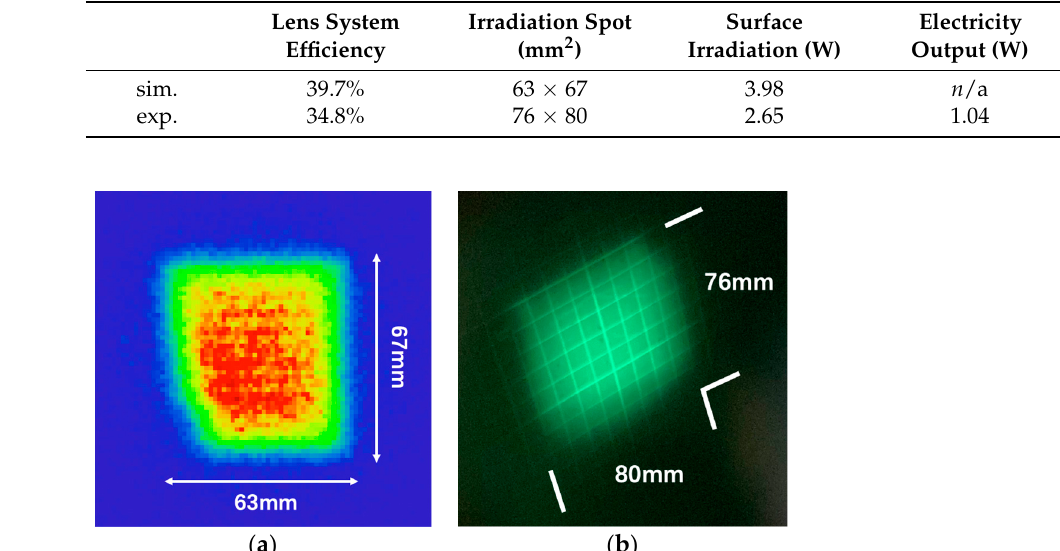
Table 2. Simulation (sim.) and experiment (exp.) results of 3 × 3 LEDs OWPT.